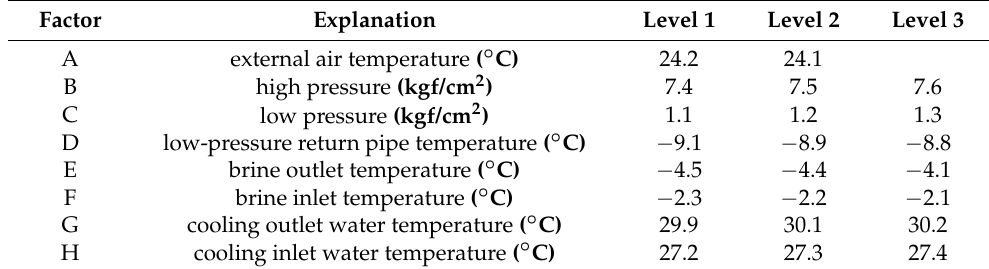
Table 5. Control factors and their